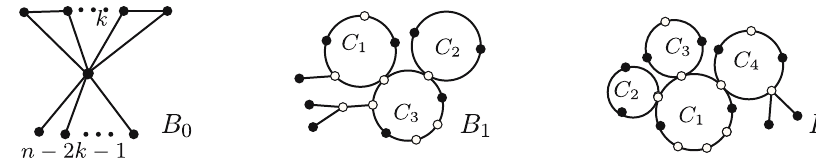
Figure 3: B 0 is used in Theorem 2.5, B 1 and B 2 attain the bound in Theorem